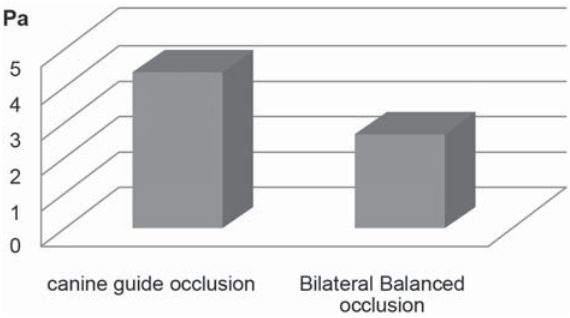
Figure 6- Values of the maximum stress in the patterns of